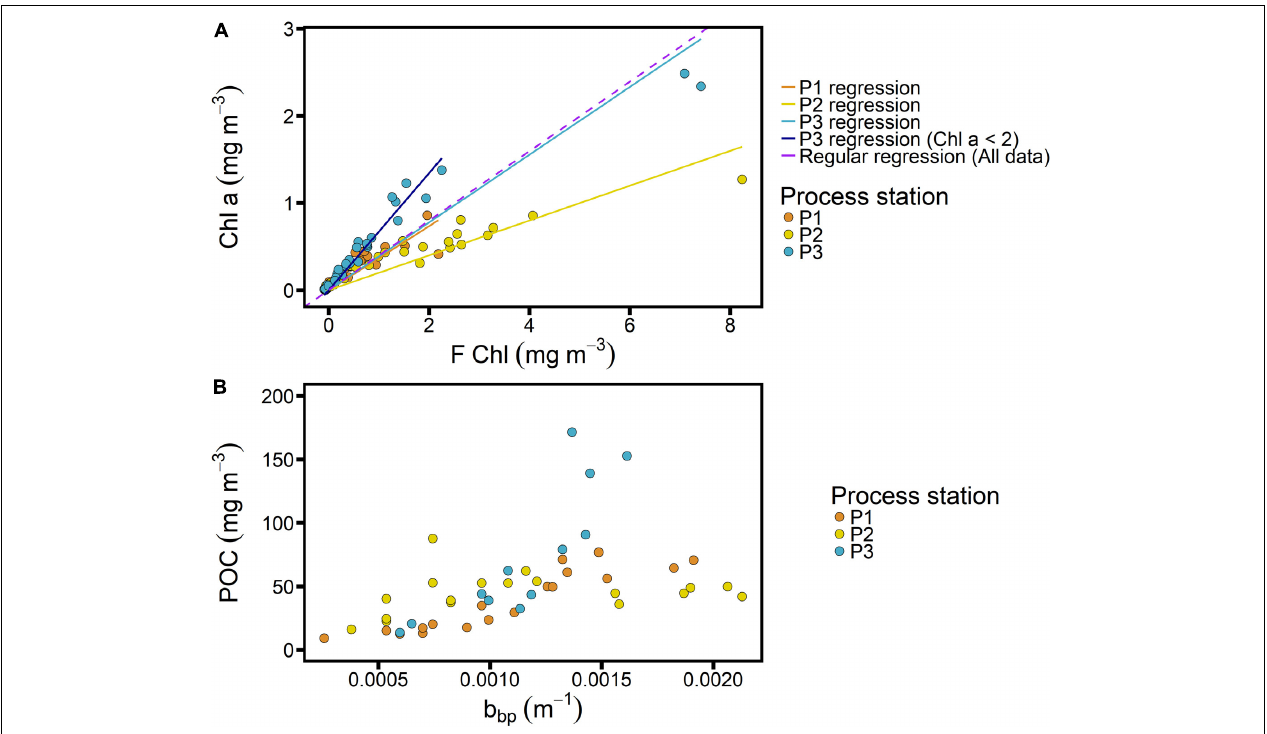
FIGURE 5 | Calibrations for Chl-F (A) and POC_b bp (B) from SAZ-Sense voyage data for process stations only (see Figure 1 for locations), with data color-coded by process station and regressions shown for individual process stations in panel (A)